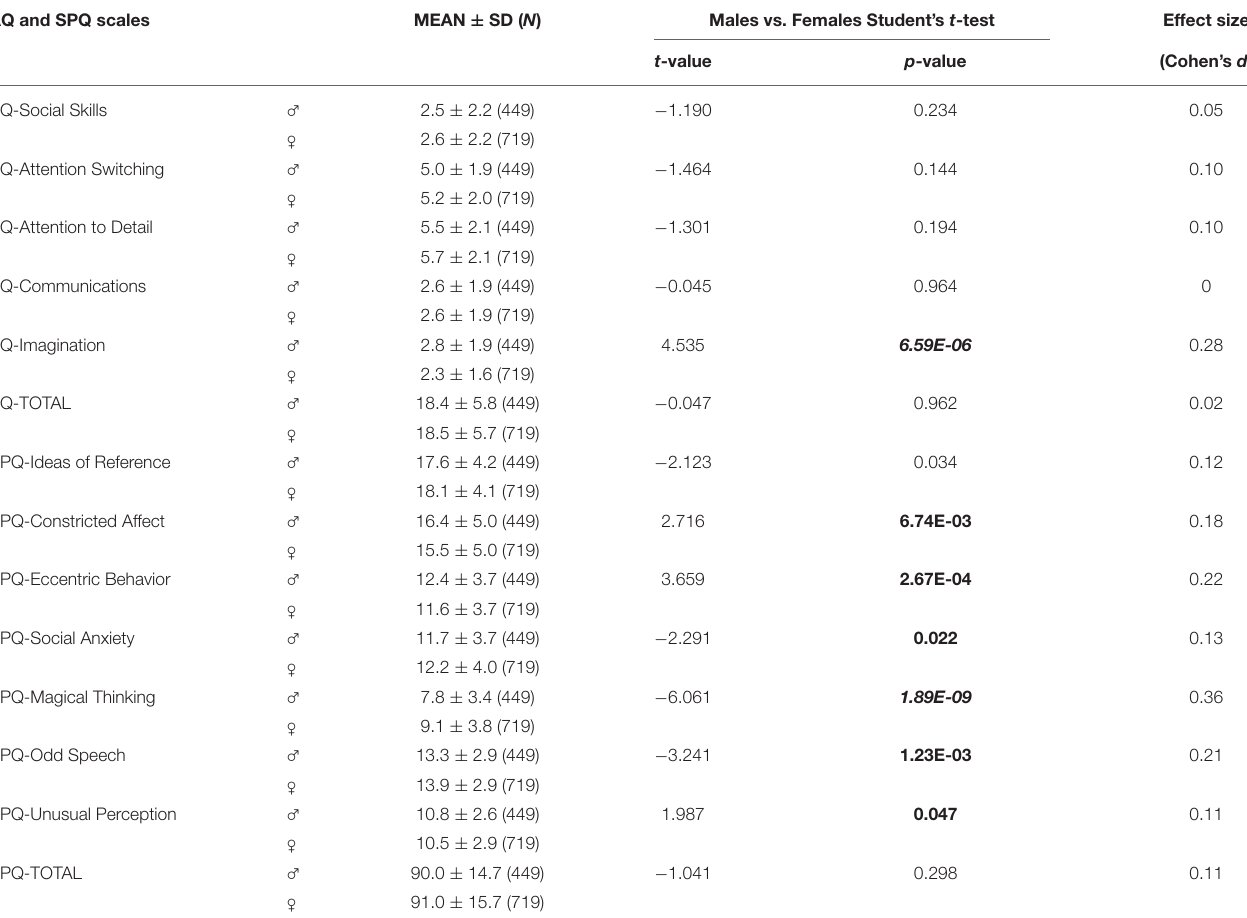
TABLE 2 | Sex differences in AQ and SPQ-BR. AQ and SPQ